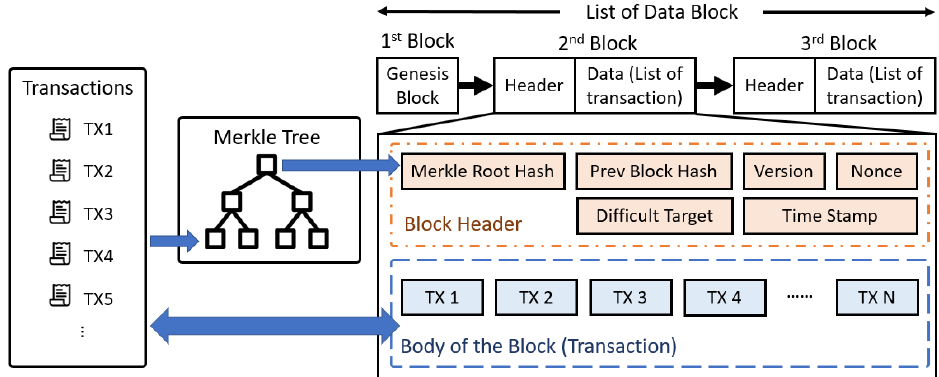
Figure 8. The process of storing data in the